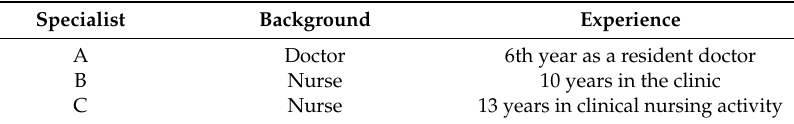
Table 2. Participating evaluation specialists’ background and experience.